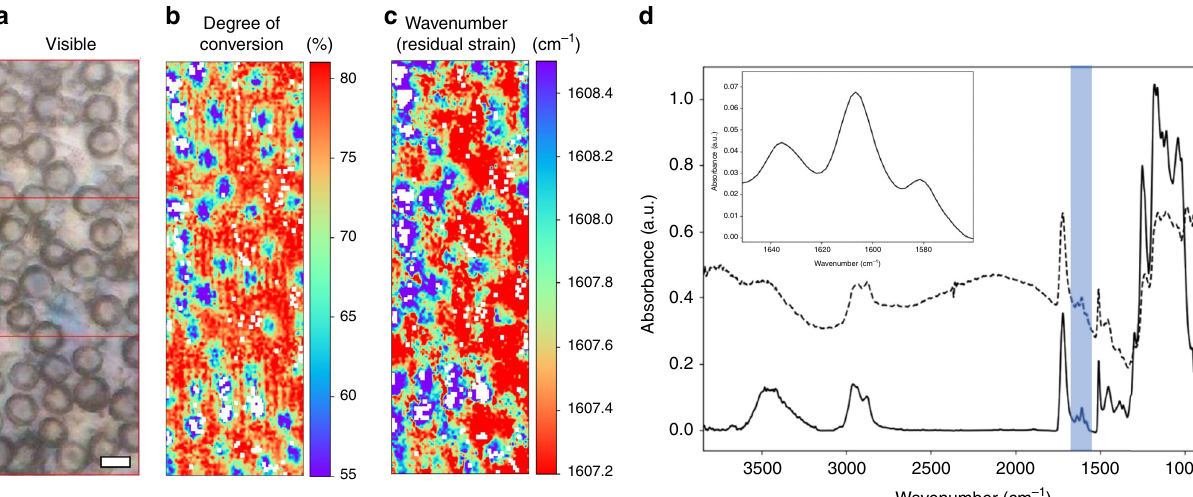
Fig. 1 Visualisation of inter-particulate conversion and residual strain in polymer composites. a Bright- fi eld visible microscope image of a TPO initiated composite composed of a 60/40 wt% (Bis-GMA/TEGDMA) resin matrix containing 50 wt% of monodisperse 8 µ m silica particles. The scale bar is equivalent to 8 µ m. b An image of reactive group conversion over the identical region shown in ( a ). Areas coloured blue and red correspond to regions of relatively low and high conversion, respectively. c A coloured image of the aromatic (1608 cm − 1 ) absorption band wavenumber position over the same region, where lower wavenumbers correspond to larger residual strain stored within the polymer (red regions). White regions correspond to spectra that either failed quality tests or where fi ts were poor. d A single Mid-IR spectrum (collected over 850 – 4000 cm − 1 , with a 2 cm − 1 resolution) from one pixel following Mie scatter corrections of the same TPO initiated composite (solid black line). A non-Mie scatter corrected spectrum (offset in the y -axis for clarity) displays characteristic background oscillations and derivative shapes which distort spectral features (broken black line). (inset) Aromatic (1608 cm − 1 ) and aliphatic (1637 cm − 1 ) absorption bands which were used to calculate the degree of reactive group conversion and relative residual strain for each pixel within an image.